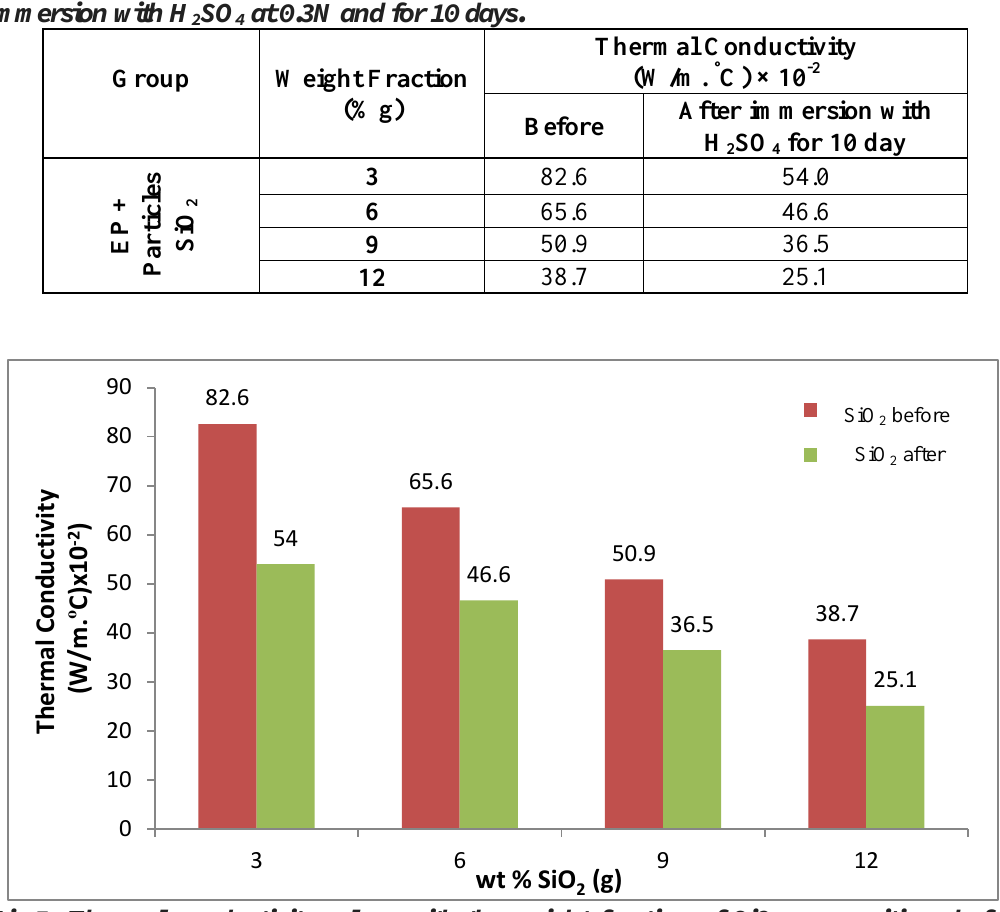
samples before and after 2